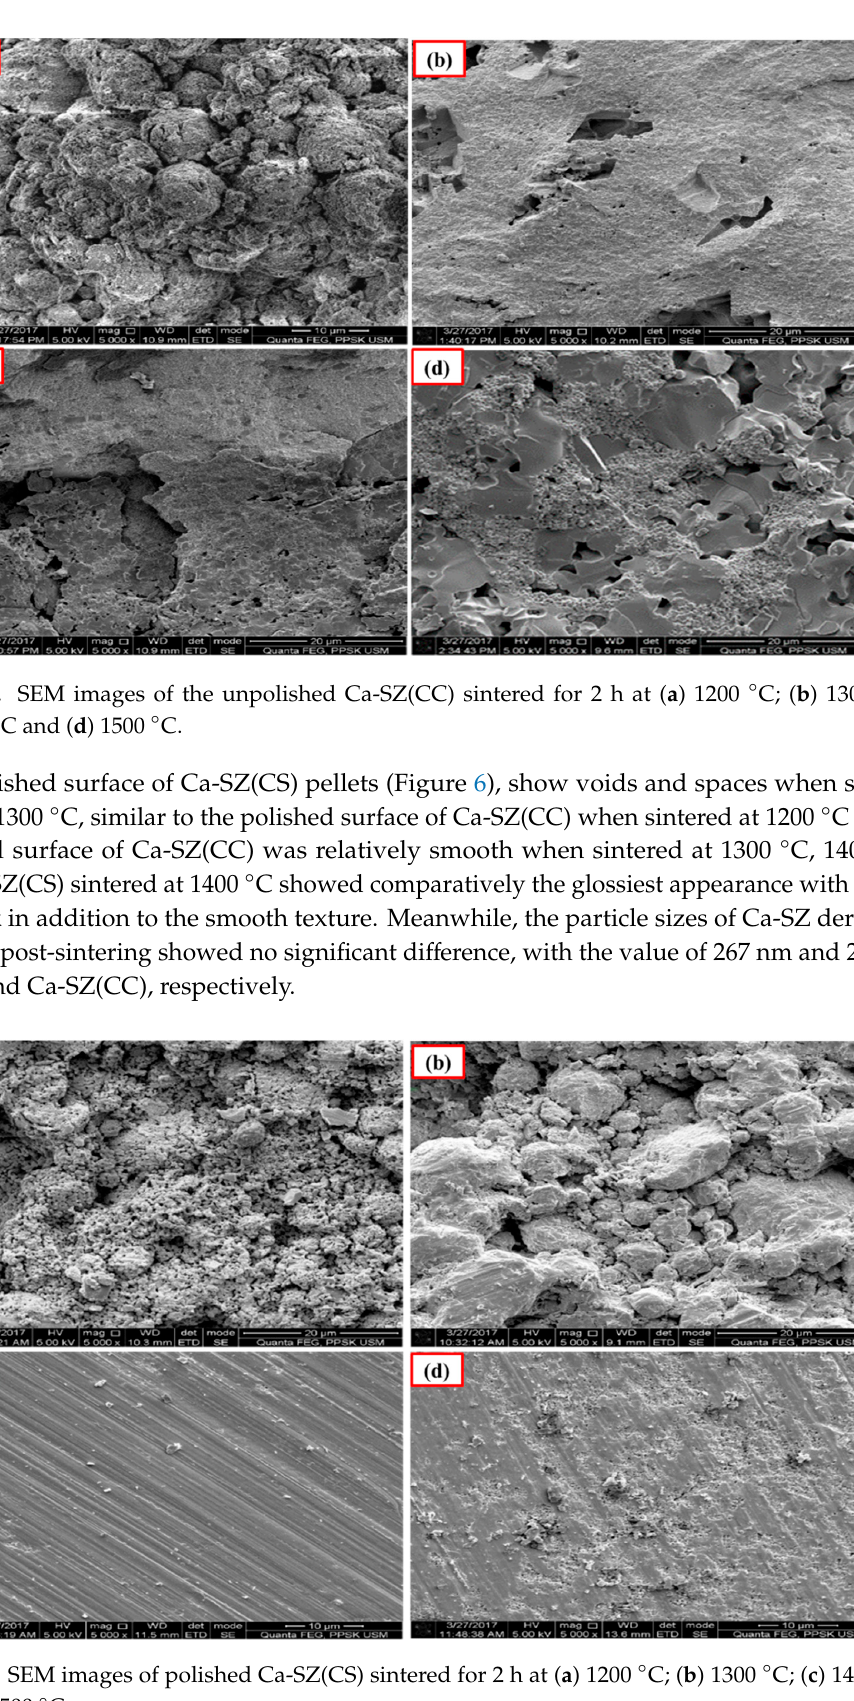
Figure 4. SEM images of the unpolished Ca-SZ(CS) sintered for 2 h at ( a ) 1200 °C; ( b ) 1300 °C; ( c ) 1400 °C and ( d ) 1500 °C.